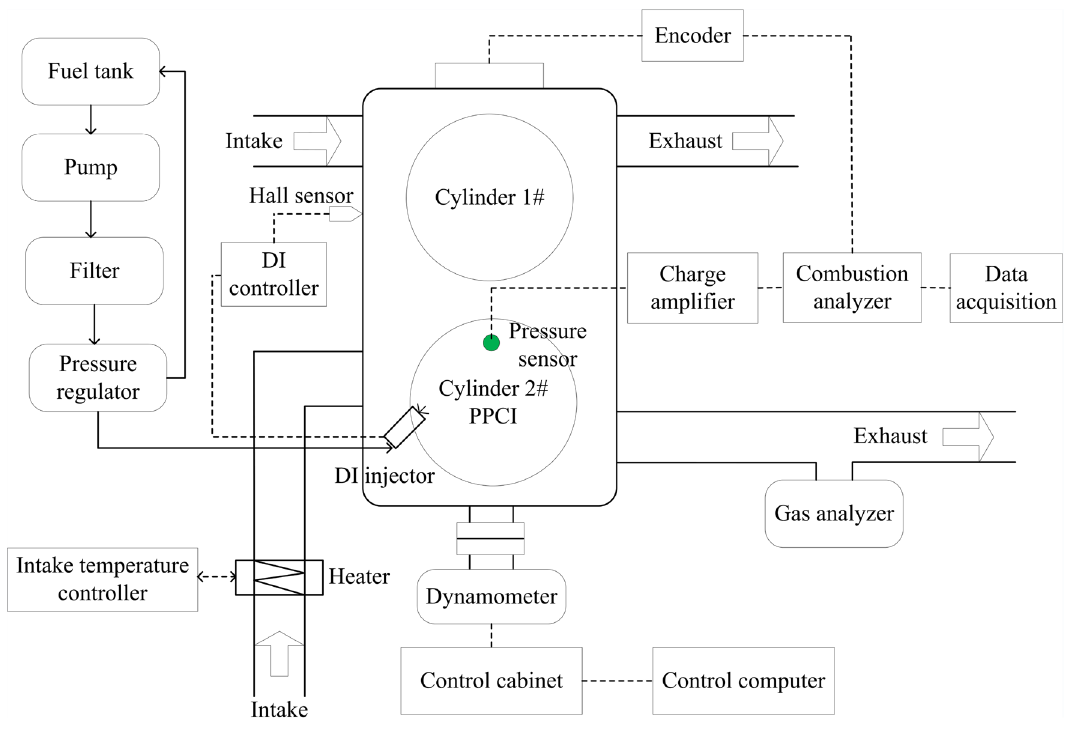
Figure 1. Schematic of engine test apparatus.